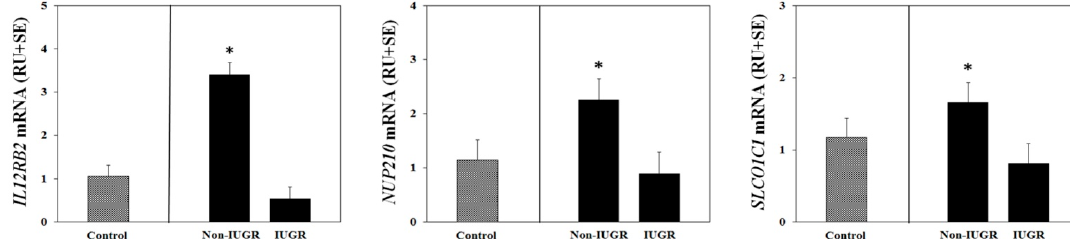
Figure 1. Select microarray-identified genes upregulated in nutrient restricted (NR) non-IUGR placetomes were validated using qPCR. Expression of IL2RB2 , NUP210 , and SLCO1C1 mRNAs were greater ( p < 0.05) in placentomes from NR non-IUGR fetuses compared to IUGR placentomes. Mean gene expression values from control ewes are included for informative comparisons only, and were not included in the statistical analysis. * Indicates p < 0.05 between NR Non-IUGR and NR IUGR placentomes.